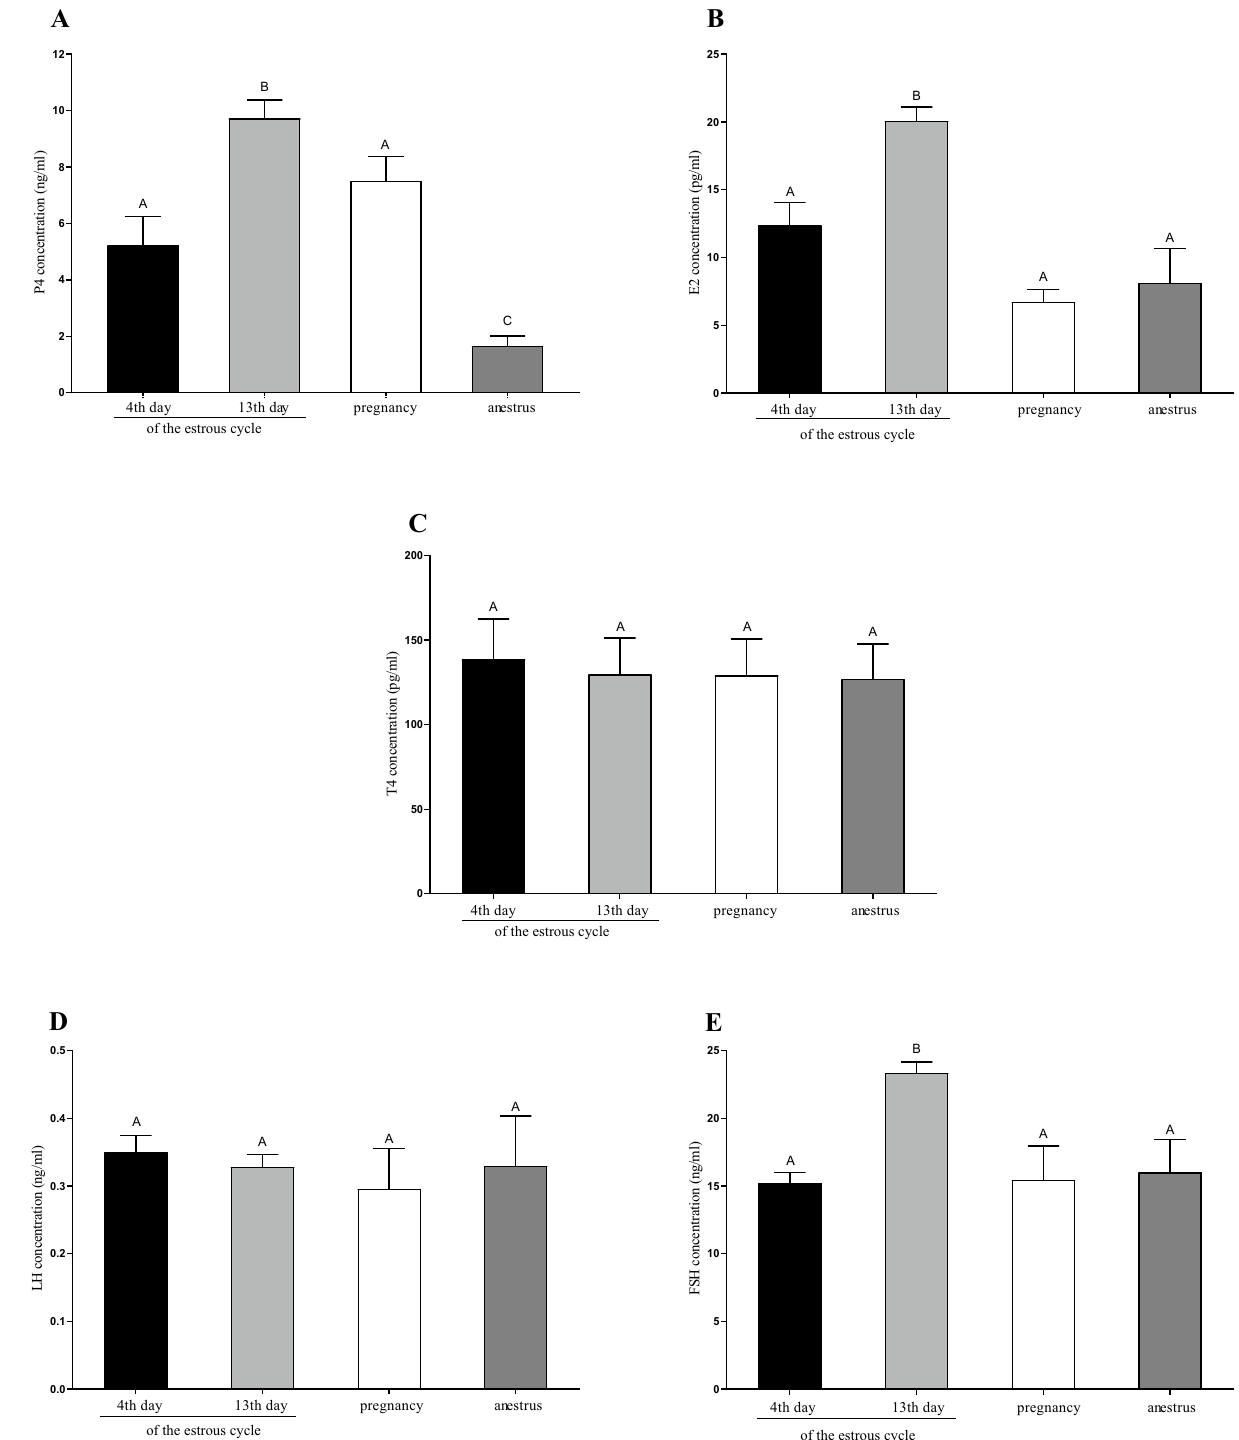
Figure 3. Plasma concentration of P4, E2, T4 LH, and FSH in the blood samples collected on 4th and 13th day of estrous cycle, in pregnancy and anestrus phase. Plasma concentrations were estimated using ELISA kits, according to the manufacturer’s instructions. Statistical differences were analyzed by one-way ANOVA, followed by Tukey’s test, using GraphPad PRISM (Version 8.3.0). The lowest statistical significance pointed by different letters (A–C) was P <